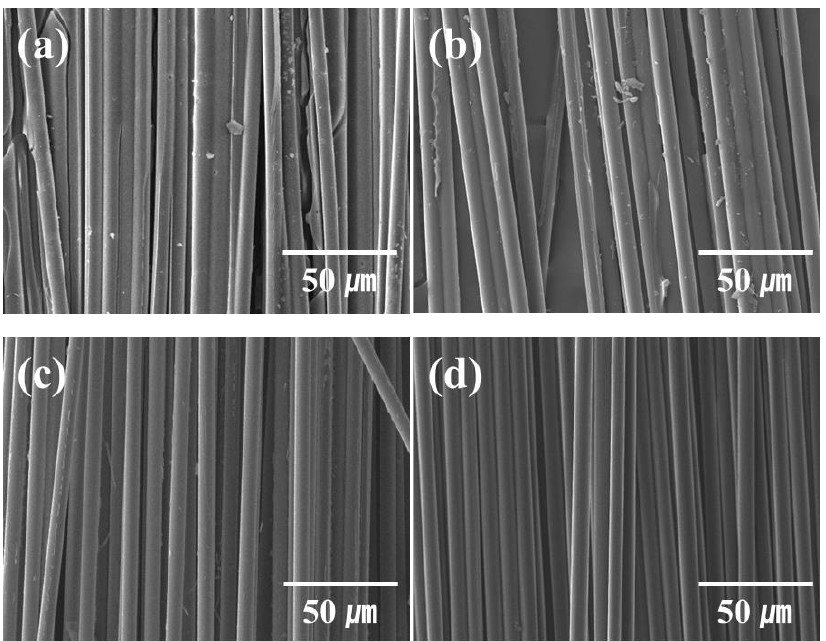
Figure 1. SEM images of waste and recycled carbon fiber (CF) acquired through different recycling methods. ( a ) CFRP scrap wastes, ( b ) recycled CFs from supercritical method, ( c ) recycled CFs from superheated steam pyrolysis, and ( d ) virgin CFs.